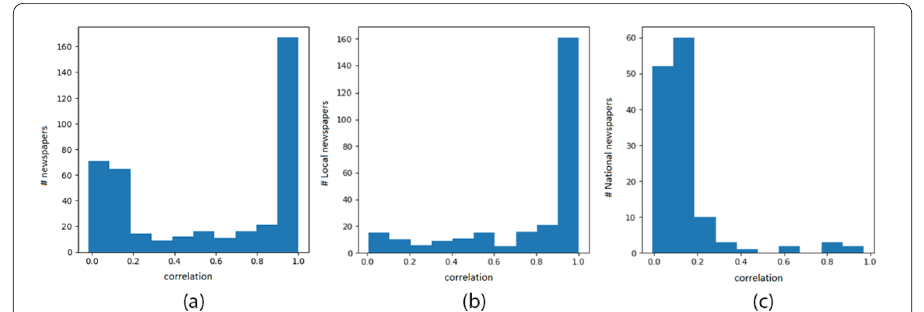
Figure 2 Distribution of the correlation coefficients (Gravity Model vs. Ground-Truth). First we show the distribution for all outlets in our database and them the distribution for two separate classes: Local-scope and National-scope news outlets